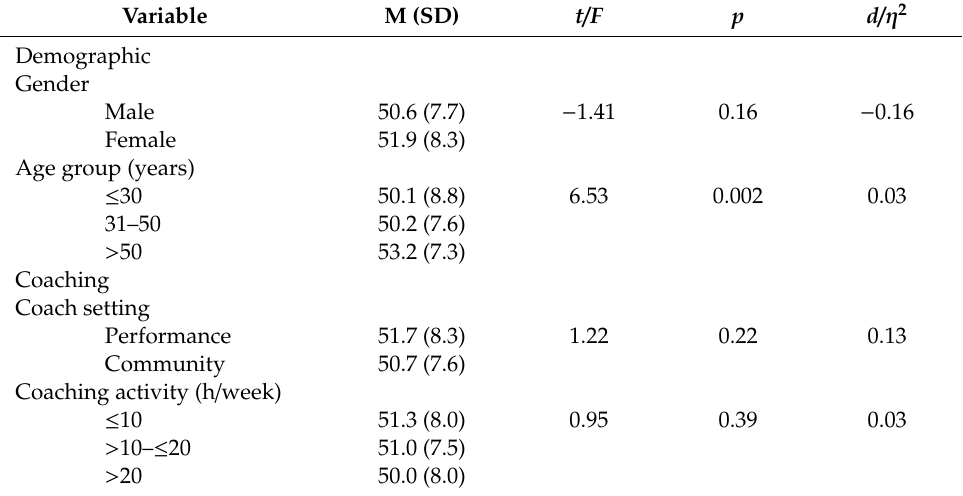
Table 2. Summary of subgroup analyses for coach well-being (Warwick–Edinburgh Mental Well-Being Scale (WEMWBS) total score).